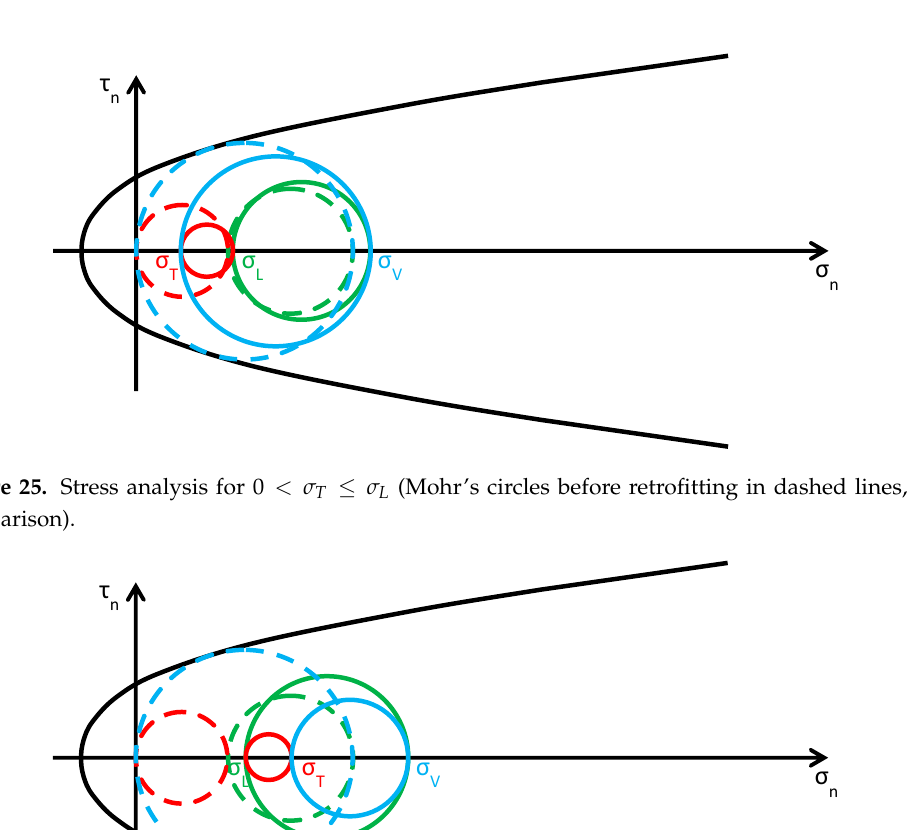
Figure 27. Stress analysis for 𝜎 (cid:3021) (cid:3408) 𝜎 (cid:3023) (Mohr’s circles before retrofitting in dashed lines, for comparison).